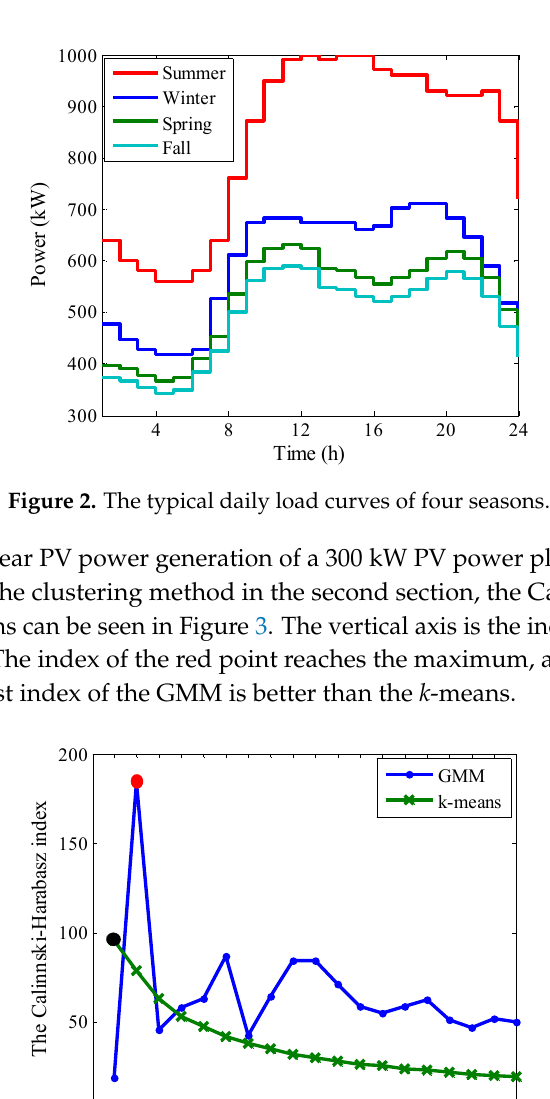
Figure 4. The cluster center curves of three PV clusters obtained by the GMM method. It is assumed that the PV and load curves are independent of each other in the following scenarios. The power rating of the energy storage system considered is 400 kW. As shown in Table 3, S1 ‒ S12 represent 12 scenarios. The first column is the capacity of the energy storage system in kW. The last column is the expected value of profits. As shown in this table, the profits generated by ESS during the whole life-cycle can be obtained under different capacity values. When the capacity is 3200 kWh, the expected value of profits is the largest. Therefore, the best Li-ion capacity is 3200 kWh when the power rating of ESS is 400 kW. Table 3. The total profits in different scenarios and capacity of energy storage. Energy of ESS (kWh)